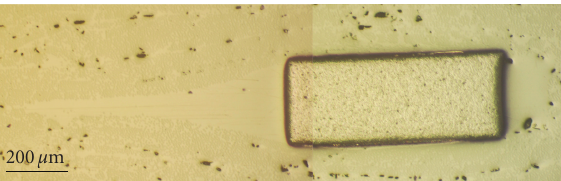
Figure 4: Photomicrograph of the resin pocket area around the embedded dummy microprocessor in ± 45 degree